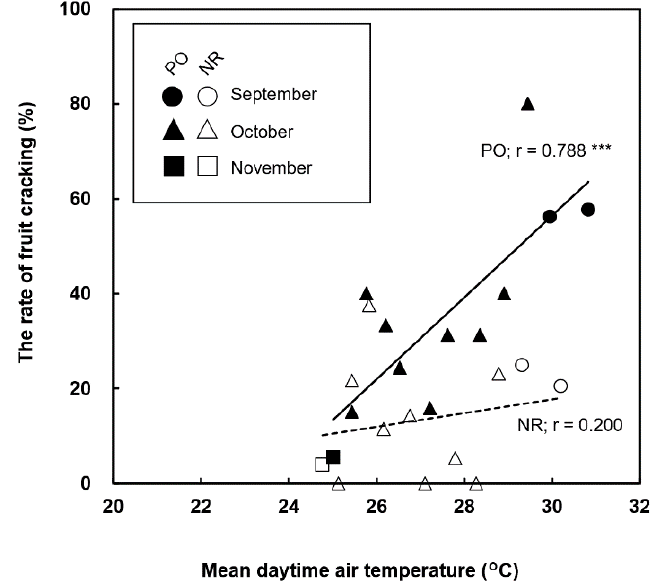
Figure 4. Pearson correlation coefficient (r) and p -value between the mean daytime temperature (7 a.m. to 5 p.m.) from flowering to harvest and the rate of fruit cracking. The circles ( ○ ●), triangles ( △▲ ), and squares (□ ■ ) indicate the rate of fruit cracking when the tomato fruit was harvested in September, October, and November, respectively. The rate of fruit cracking was calculated as the number of cracked fruits divided by the total number of harvested fruits for each harvest date ( n = 12). Asterisks (***) indicate significant correlation at p <